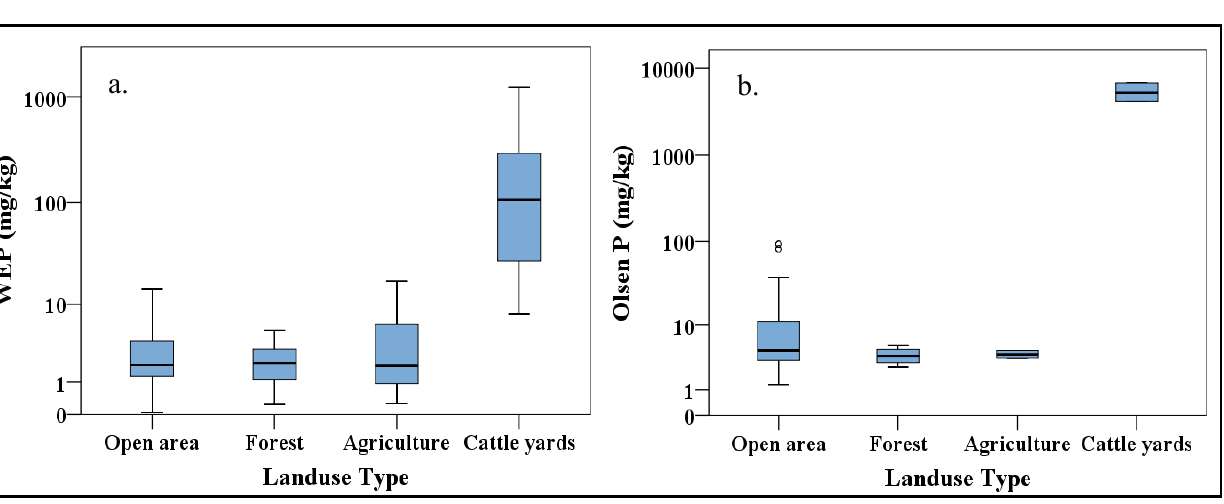
(Table 4). On the other hand, the correlation between the P-index results and the measured total P was less consistent, especially during the rainfall–runoff event of January 2010 where a low r 2 value of 0.14 was computed. Figure 3. Distribution of ( a ) water-extractable P (WEP); and ( b ) Olsen-P in the four selected land-use areas of Hermon catchment.